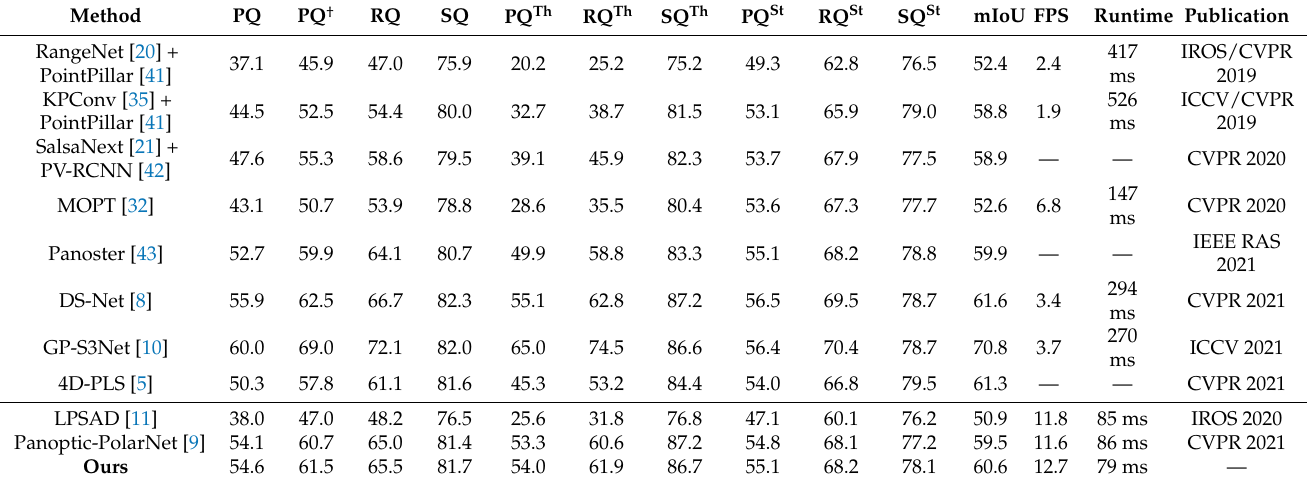
Table 2. Comparison of LiDAR-based panoptic segmentation performance on the test split of SemanticKITTI. Metrics are provided in [%], and FPS is in